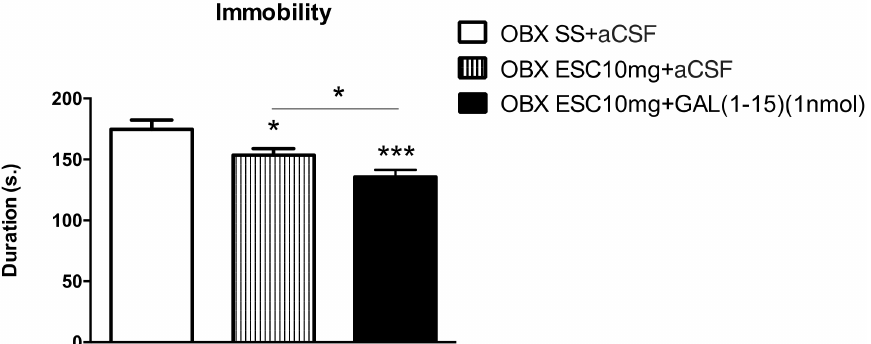
Figure 2. Behavioural effects of the coadministration of effective dose of ESC (10 mg/kg) and GAL(1- 15) (1 nmol) in the tail suspension test (TST). Saline or ESC was administered intraperitoneal (ip) 23, 5, and 1 h before the test. aCSF or GAL(1-15) was injected intracerebroventricular (icv) 15 min before the test. Data represent mean ± SEM of immobility time in TST during the 6 min test period (n = 8–10 rats per group). * p < 0.05 versus OBX SS+aCSF, *** p < 0.001 versus OBX SS+aCSF group; according to one way ANOVA followed by Fisher multiple comparison